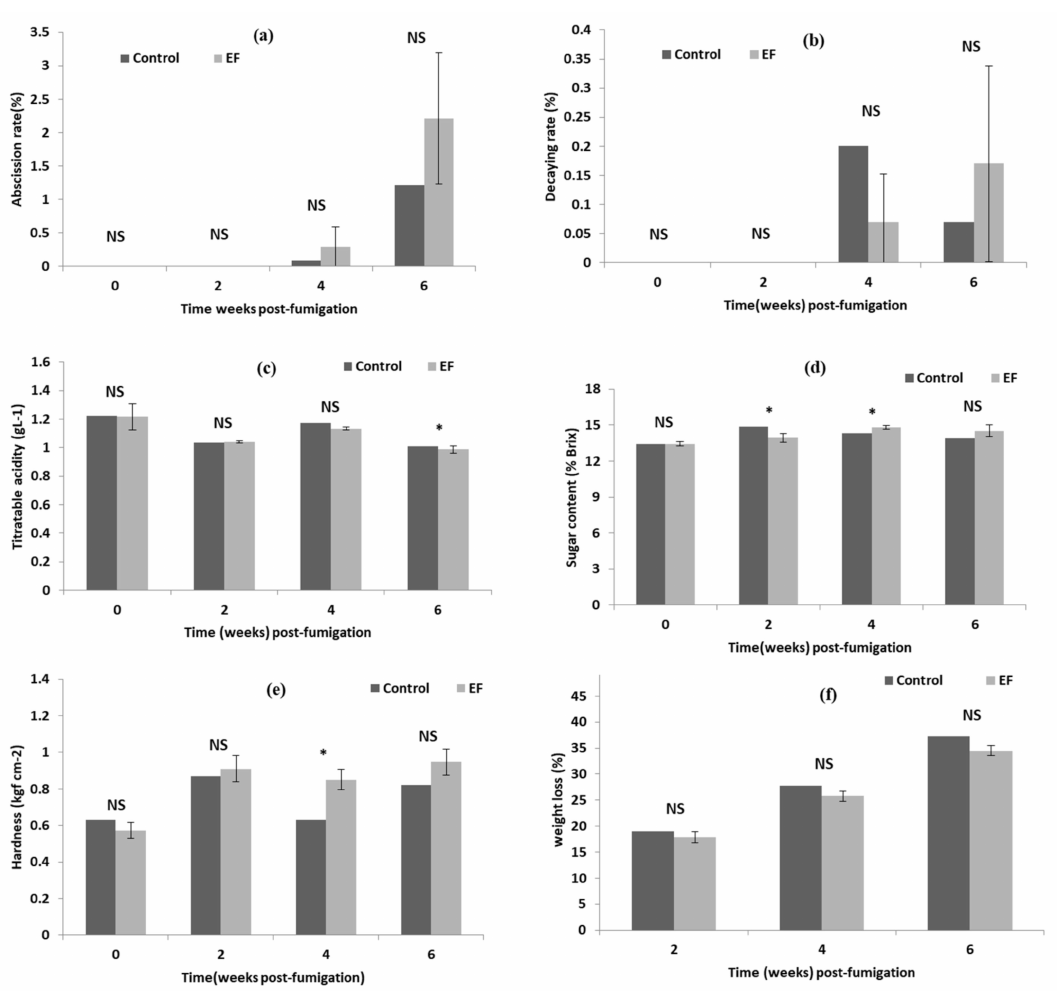
Figure 6. Phytotoxicity assessment of grapes (Campbell Early) post-fumigation, after treatment with 70 g/m 3 EF for 4 h at 5 ◦ C. All data were analyzed using Fisher’s least significant difference ( p = 0.05). NS indicates no significant differences between the EF treatment and untreated control; * indicates significant difference between the EF treatment and untreated